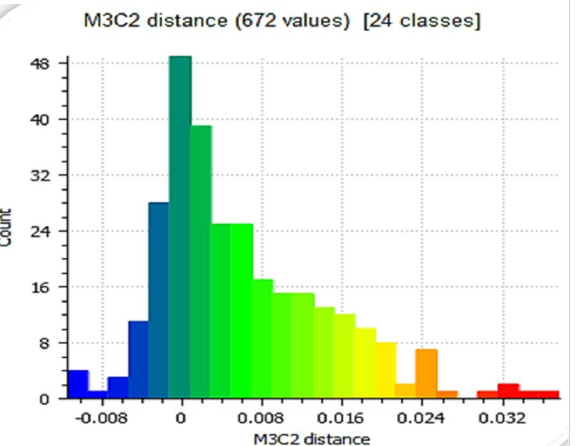
Figure 9. Display of a histogram showing how successfully the two 3D edges projected in Figure 8 as adapted to each other (differences in